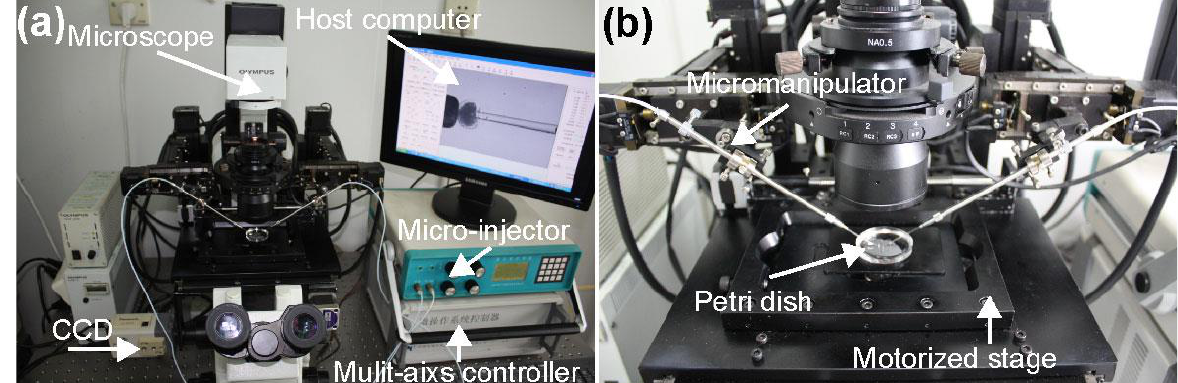
Figure 1. The NK-MR601 micro-manipulation system. ( a ) System setup; ( b ) micro operation workspace.